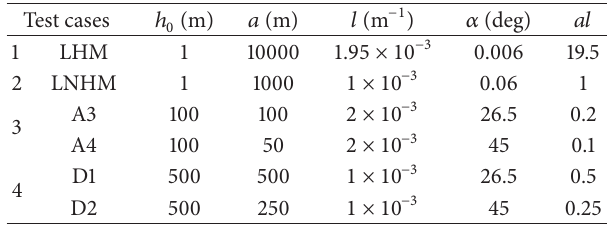
Table 1: Configuration of mountains in different test